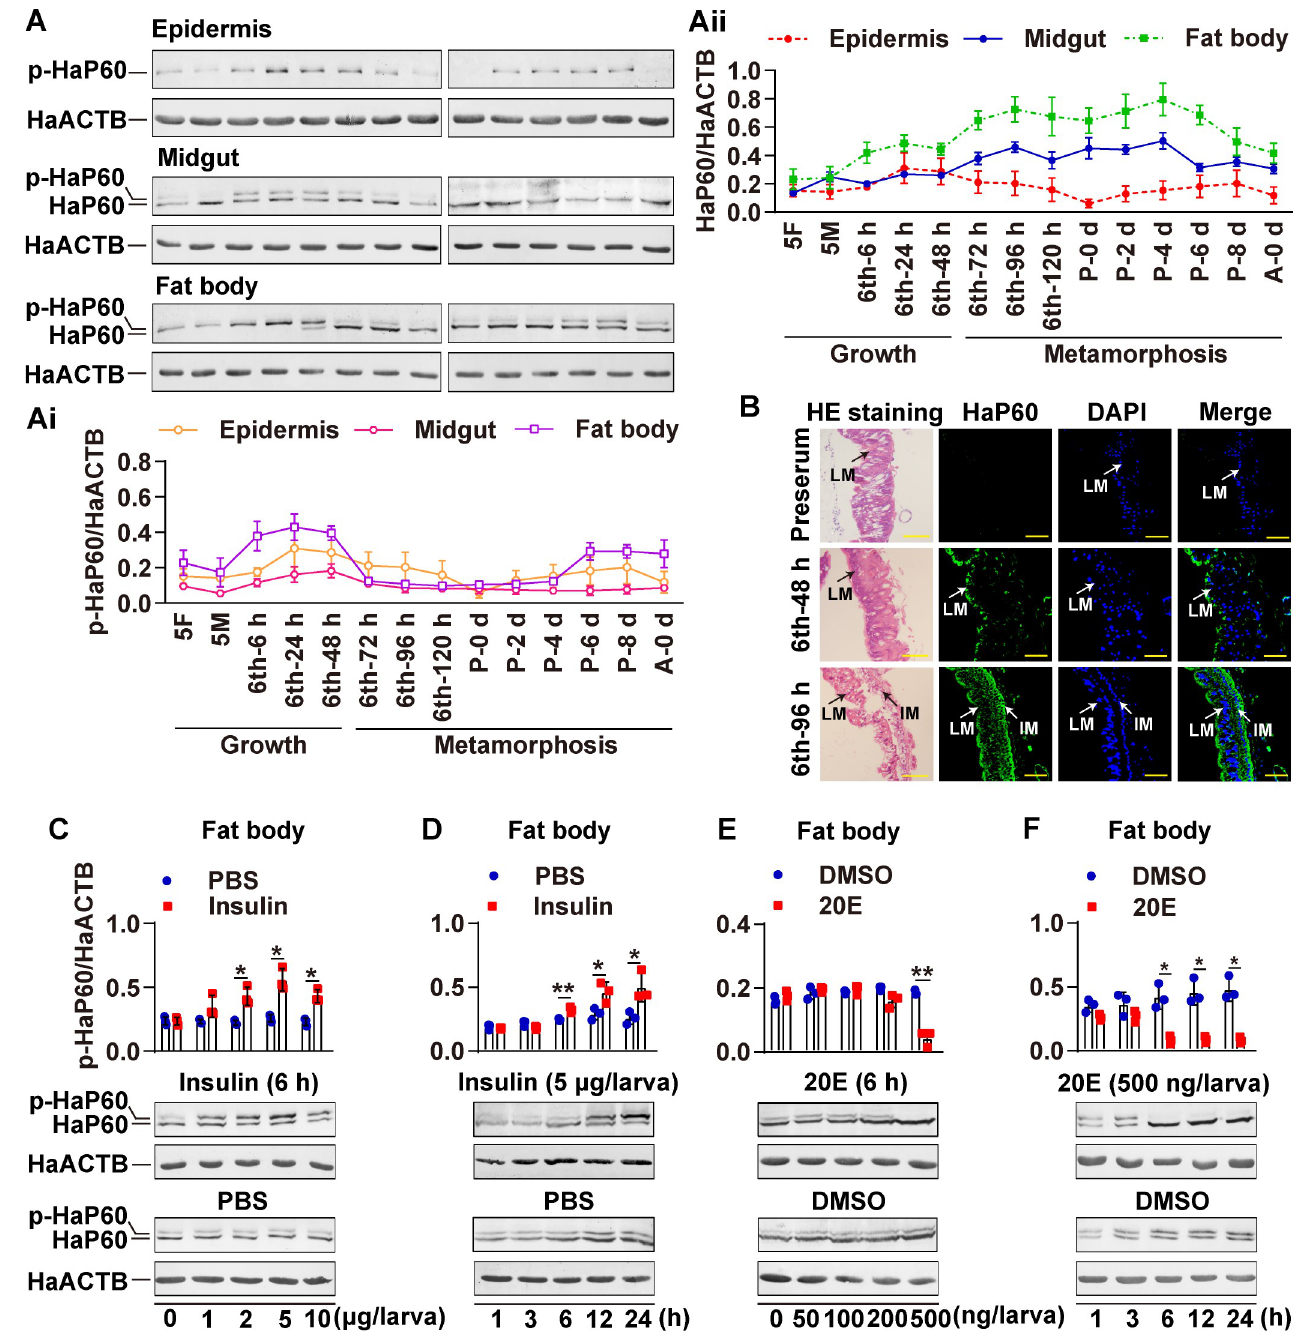
Fig 1. 20E promoted HaP60 dephosphorylation and expression. A. Western blotting detection of the expression profiles of HaP60 from the fifth instar to adult in different tissues using anti-HaP60 antibodies. 5F, fifth instar feeding; 5M, fifth instar molting; 6th-6 h-120 h, sixth instar 6 h-120 h; P 0 d-P 8 d, pupa 0 d-8 d; A 0 d, adult 0 d. Ai. The quantitation of phosphorylated HaP60 in A. Aii. The quantitation of HaP60 in A. B. HE staining and immunohistochemistry showing HaP60’s location in the midgut of 6th-48 h and 6th-96 h. Green, HaP60 detected using anti-HaP60 antibodies; blue, nuclei stained using DAPI; merge, overlapped with green and blue; IM, imaginal midgut; LM, larval midgut. Bar, 20 μ m. C and D. Insulin elevated HaP60 phosphorylation in a dose and time dependent manner, respectively. E and F. 20E promoted HaP60 dephosphorylation and expression in a dose and time dependent manner, respectively. All experiments were repeated at least three times. Every column contained three blue dots or red squares represents the quantitation of independently repeated three experiments. � P < 0.05 and �� P < 0.01 using two-tailed Student’s t -test. The bars indicate mean ± SD.